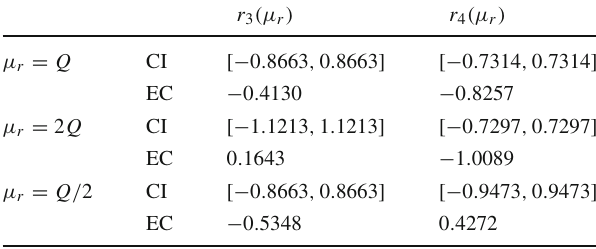
LO (dotted), given NLO (dotdashed), given N 2 LO (solid)